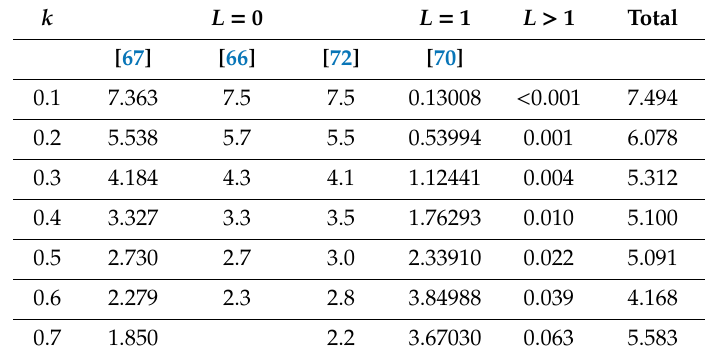
) for positron–hydrogen Table 15. Z e ff ( π a 2 0